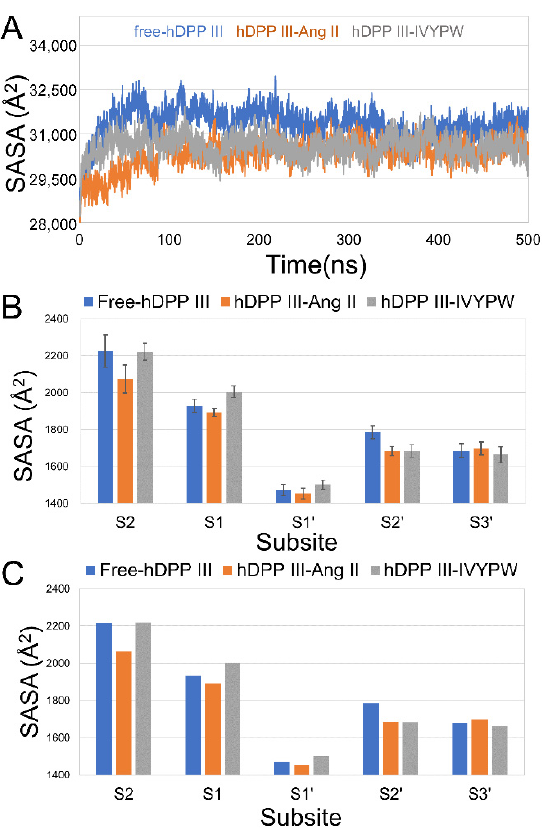
Figure 4. ( A ) SASA plot of the three systems over 500 ns. ( B ) The average of SASA values of each subsite in the last 200 ns. ( C ) The median of the SASA values of each subsite in the last 200 ns.